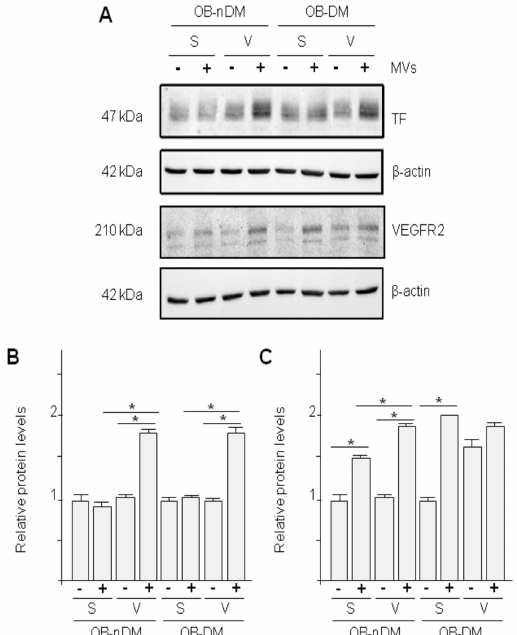
Figure 8. E ff ect of ASCs-MVs on protein expression in protein endothelial cells. ( A ) TF and VEGFR2 protein expression in migrating endothelial cells treated with media with ( + ) or without (-) MVs obtained from 48 h cultured of subcutaneous (S) or visceral (V) ASCs from patients with obesity without diabetes (OB-nDM) or with diabetes (OB-DM); ( B ) Quantitative analysis of TF to β -actin relative levels; ( C ) Quantitative analysis of VEGFR2 to β -actin relative levels. (* p <